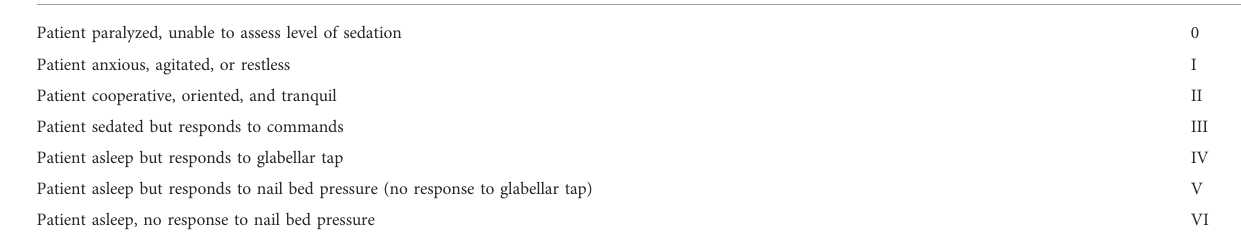
TABLE 1 Ramsay scale for the level of sedation and analgesia (Rudner et al.,